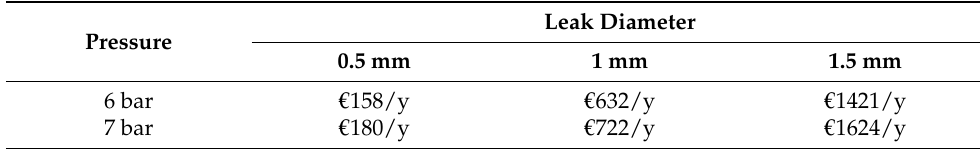
Table 1. The annual financial repercussions of differently sized leaks